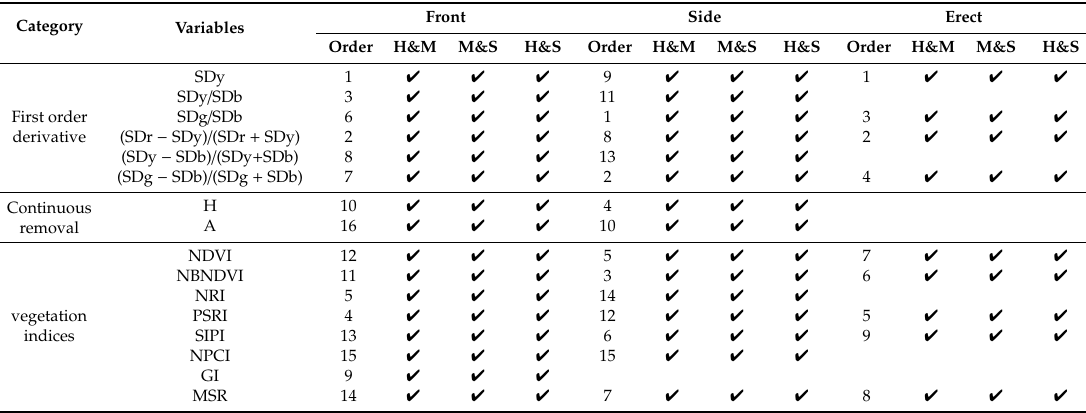
Table 8. Selected spectral feature